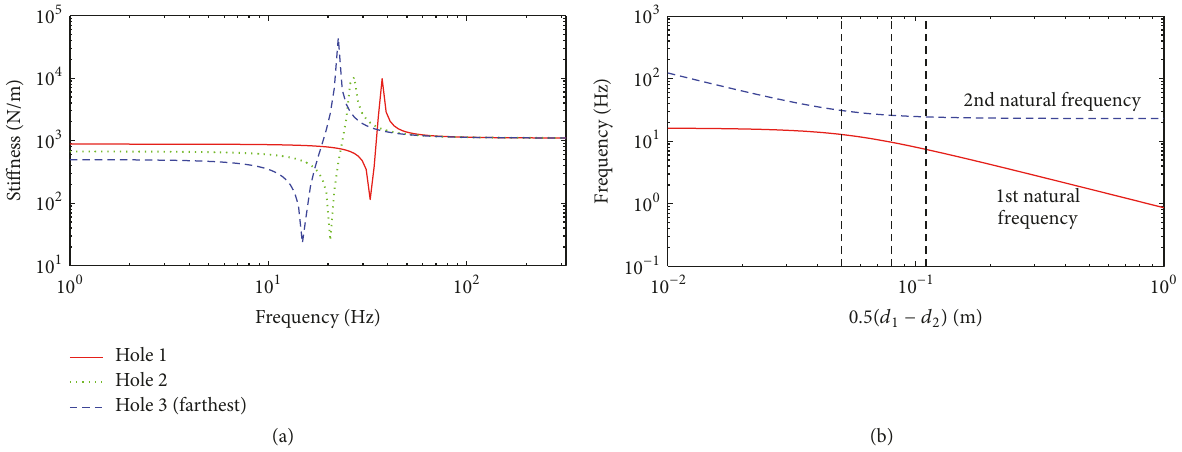
Figure 2: (a) The variation of stiffness for the three cases and (b) two undamped natural frequencies.